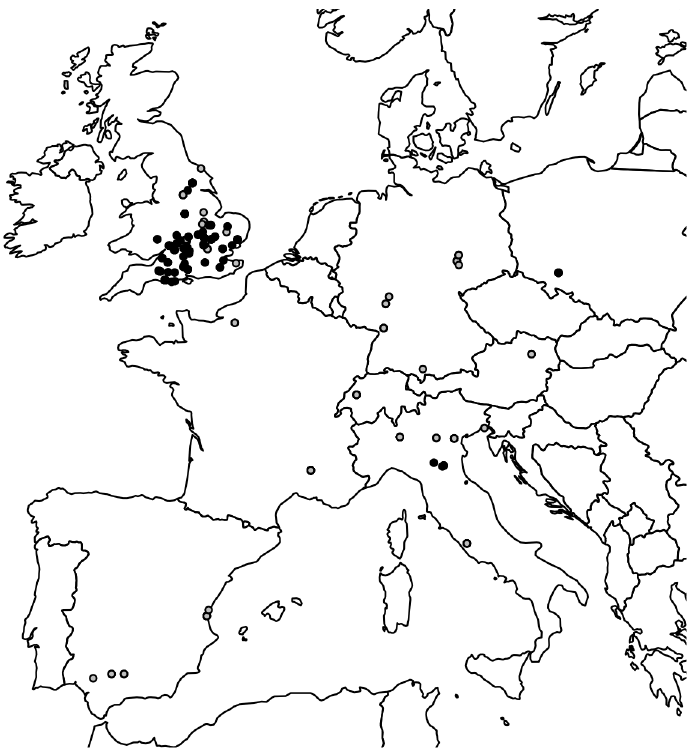
Fig 1. Geographical distribution of the prone burials and burials with the cephalic extremity displaced. Each dot represents a site. Grey and black dots indicate, respectively, prone burials and burials with the cephalic extremity displaced. Note the wide distribution of prone burials in both Continental Europe and Britain, and the cluster of burials with the cephalic extremity displaced in the latter.